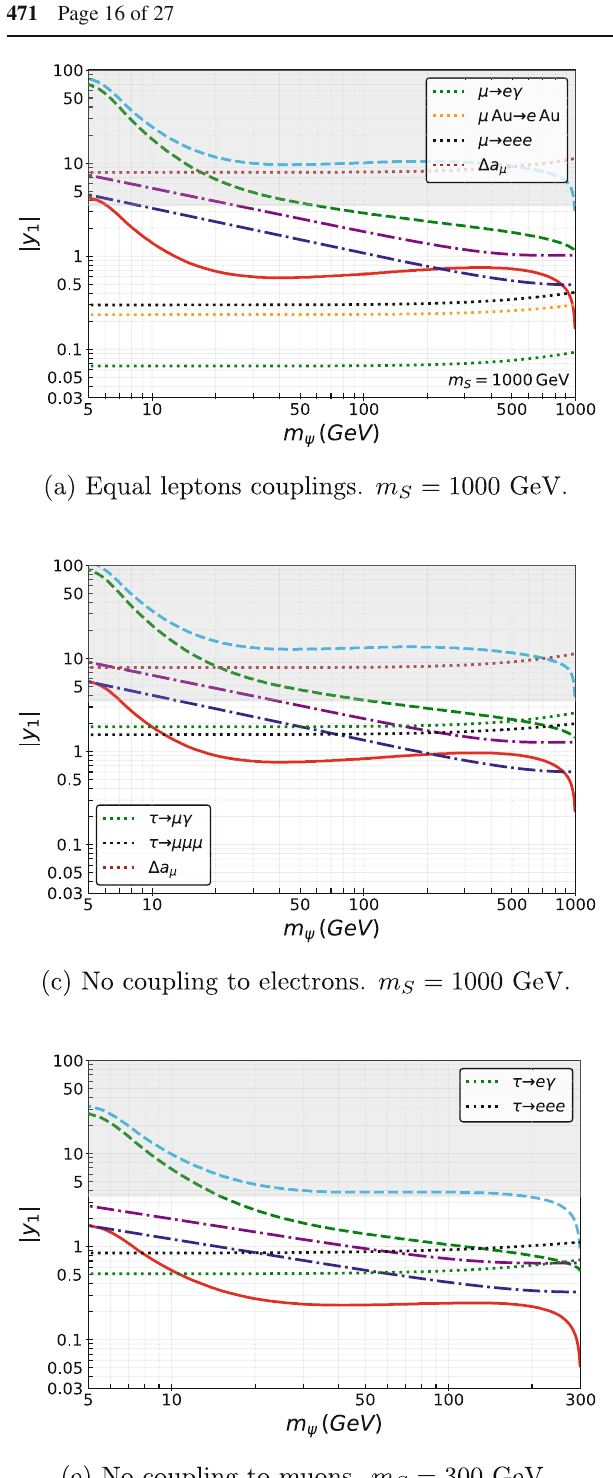
Fig. 6 Combined direct detection 90% C.L. limits for Dirac dark mat- ter (solid red), and Majorana dark matter with λ HS = 0 . 1 (dashed light blue) and λ HS = 3 (dashed green), with right-handed charged leptons in the loop. Contours of the correct relic abundance set by ψψ → (cid:5) α (cid:5) β